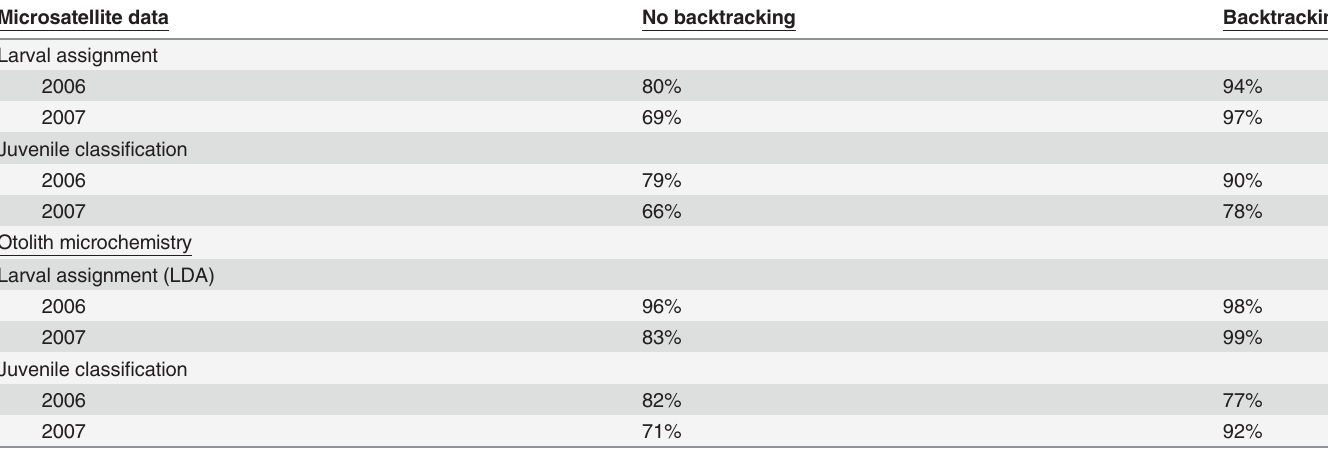
The backtracking column includes only the data using the 90% con fi dence threshold for larval hatching location assignment. The data also include only larvae < 8 mm